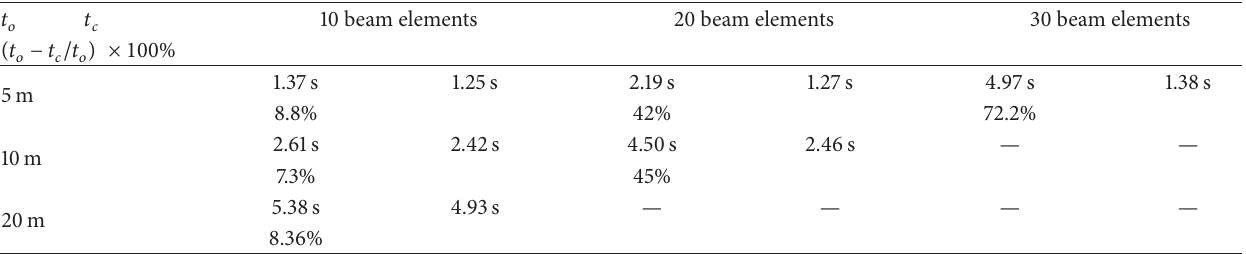
Table 3: Computation times of the original and condensed moving load models with different beam lengths or numbers of beam elements. 𝑡 𝑜